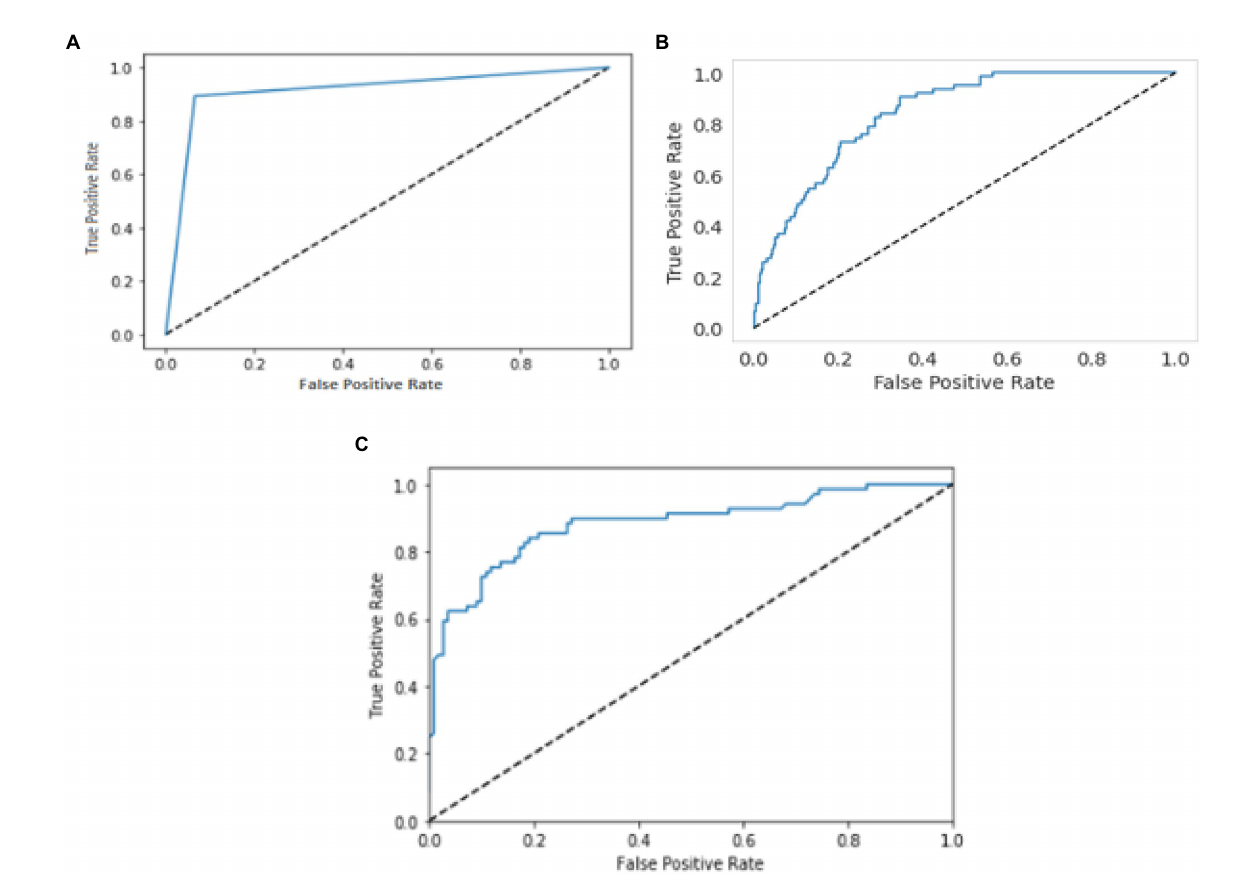
FIGURE 7 ROC curves for three models. Whereby (A–C) represents the performance of the YOLO V3, MobileNet, and RCNN, respectively, to detect carotid plaque from MRI scans for stroke risk assessment.